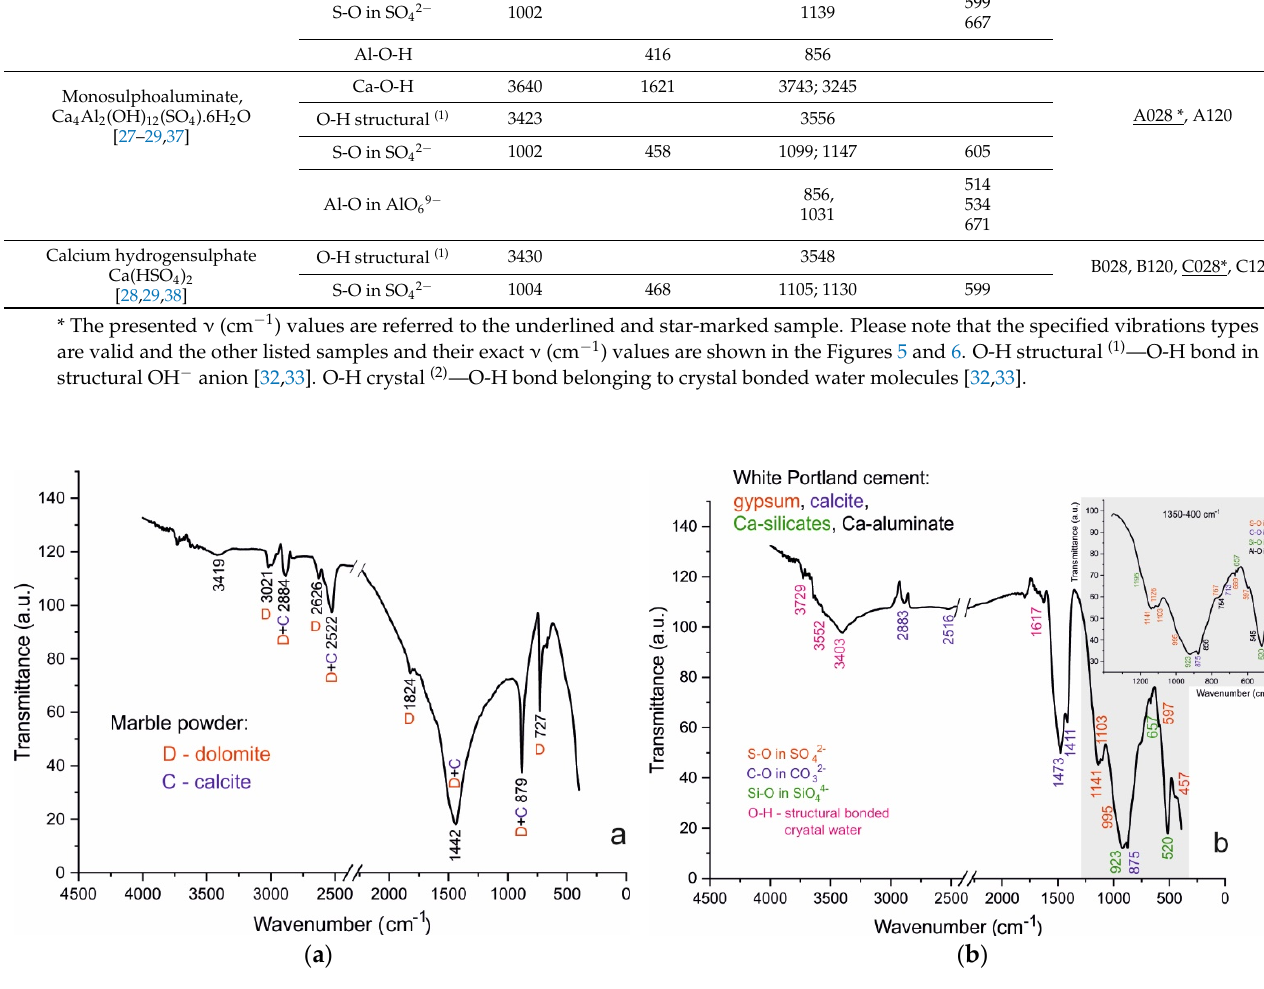
Figure 4. ( a ) FTIR spectra of raw materials marble powder; ( b ) FTIR spectra of raw materials white Portland cement. Insertion: magnification of spectral range 1350–400 cm − 1 for white Portland cement.